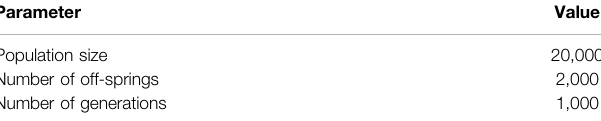
TABLE 12 | Parameters for the genetic algorithm NSGA-II.